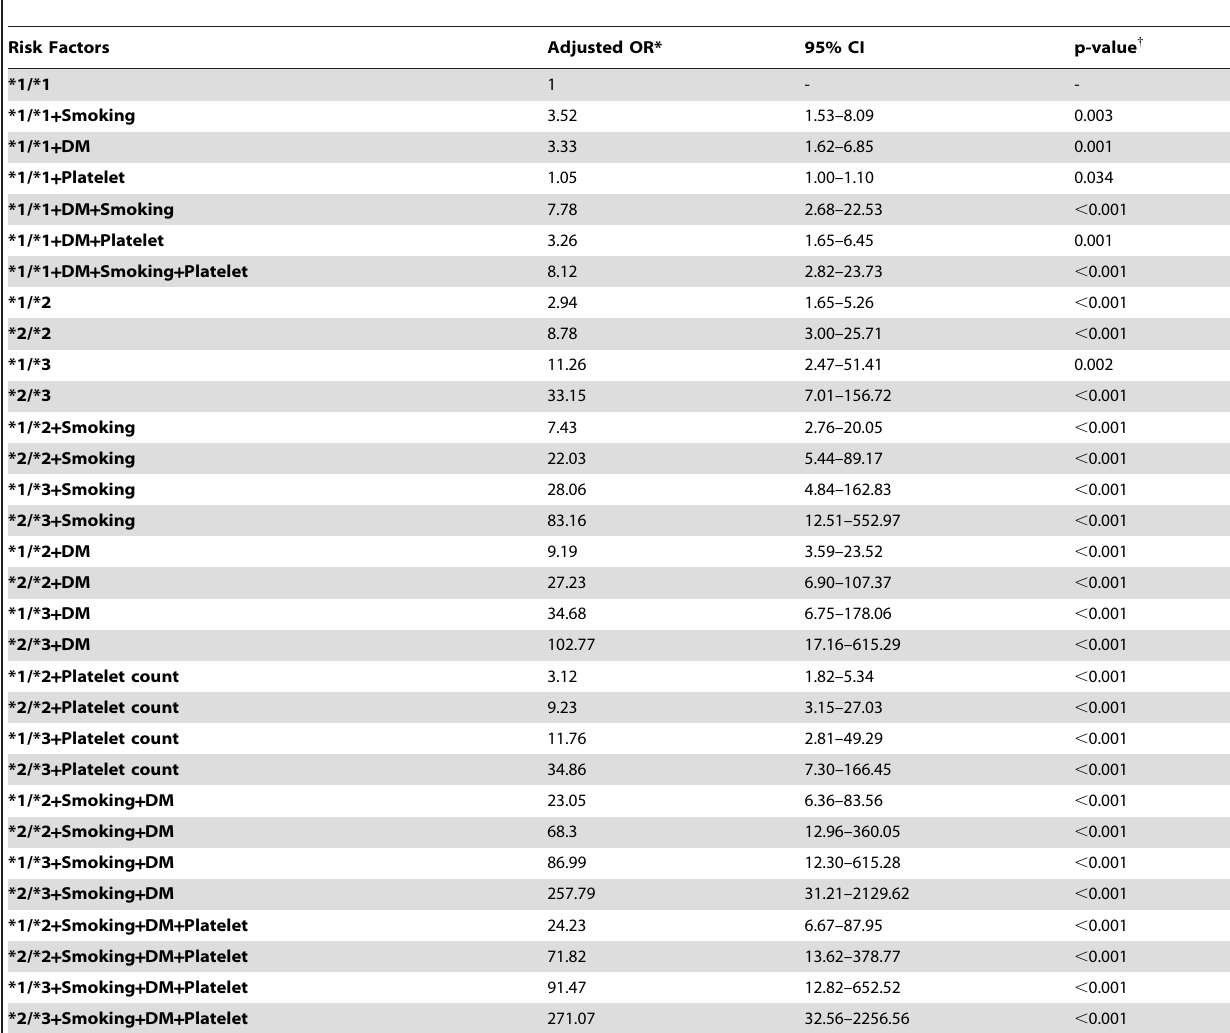
Table 4. Estimated risk of clopidogrel resistance in patients with at least one of the following risk factors: CYP2C19*2, CYP2C19*3, smoking, diabetes mellitus, increase in platelet count adjusted for age and